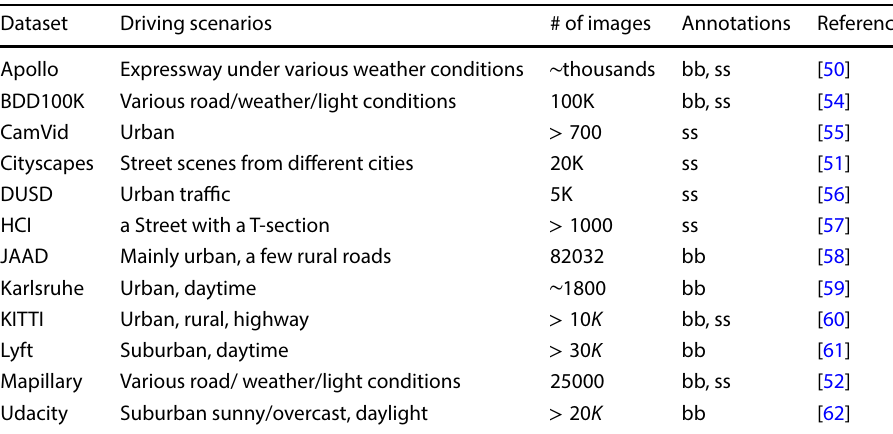
bb stands for bounding boxes and ss stands for semantic segmentation